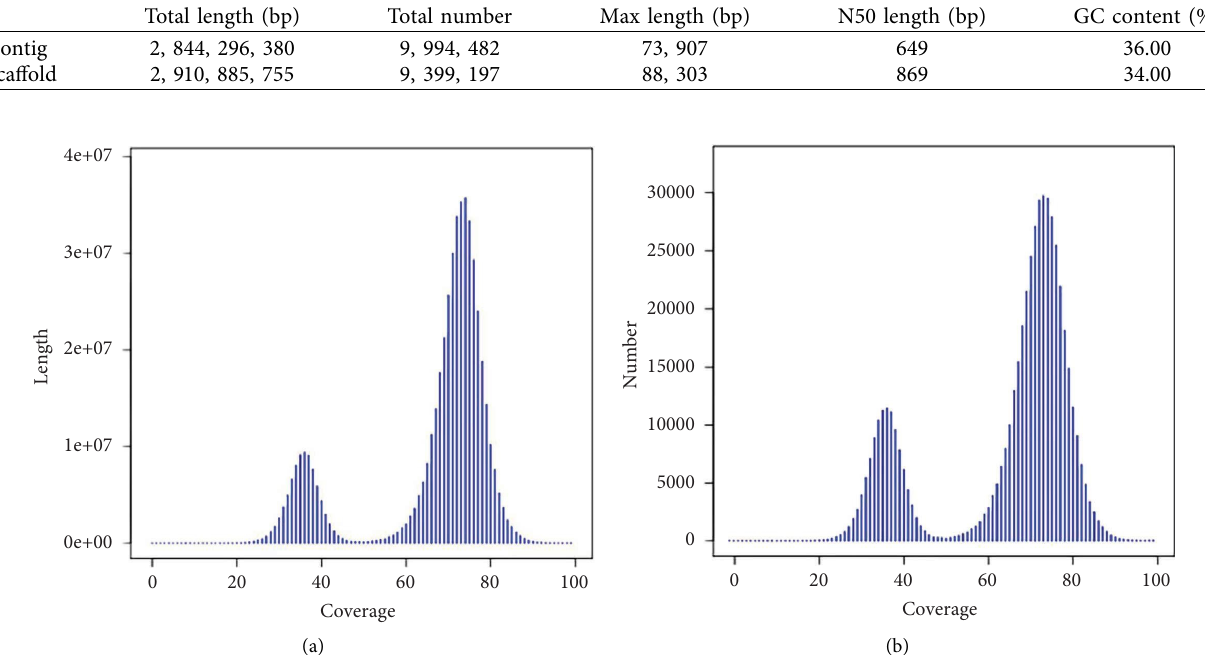
Figure 2: Contig distribution of the CNC genome. (a) Distribution graph of contig coverage depth and length and (b) distribution graph of the CNC contig coverage depth and number. In the fgure, the peak with the highest distribution was the main peak. Te heterozygosity of the genome was judged according to the peak of 1/2 position before the main peak.